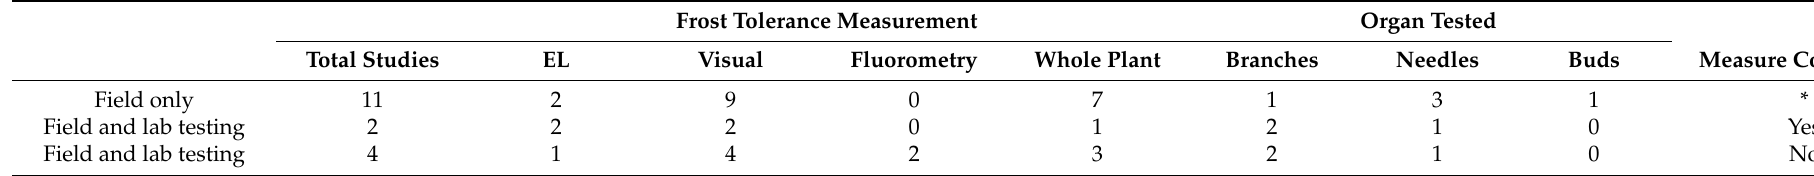
Table 3. Studies that included field observations.